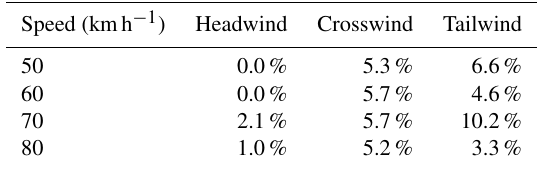
Table 3. Percent difference between mean short and tall anemome- ter measurements across vehicle